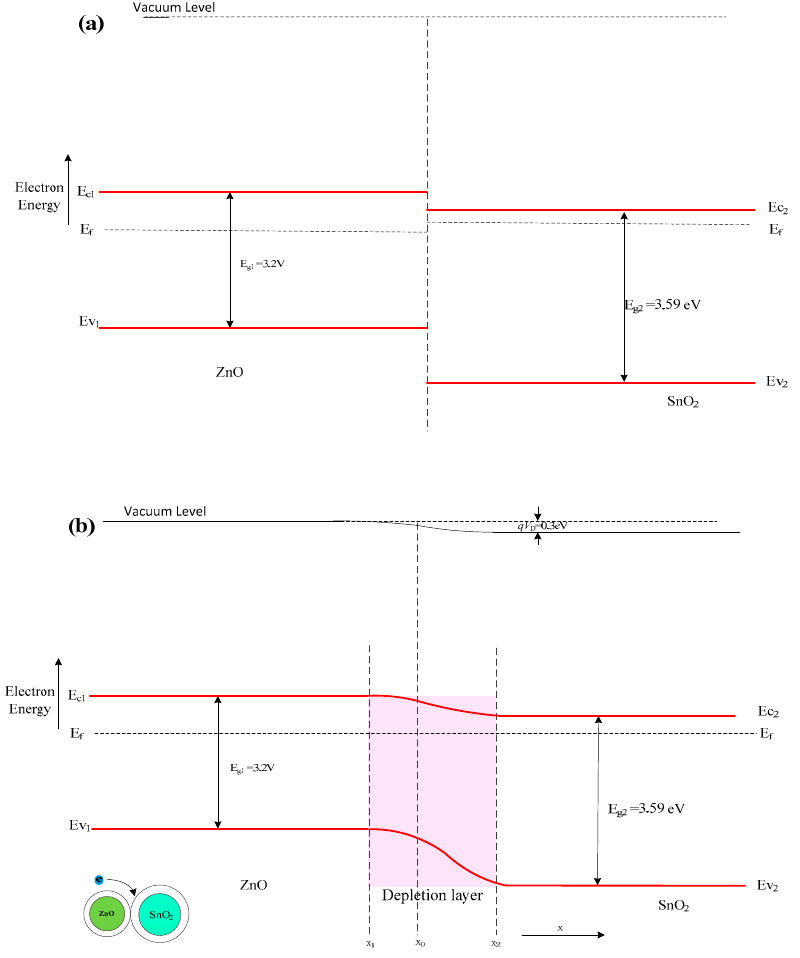
Figure 10. Energy band diagram of the electrospun SnO 2 /ZnO 3D hetero-nanofibers system. ( a ) Energy band diagram of SnO 2 /ZnO 3D hetero-nanofibers system before equilibrium. ( b ) Energy band diagram of SnO 2 /ZnO 3D hetero-nanofibers system at equilibrium.